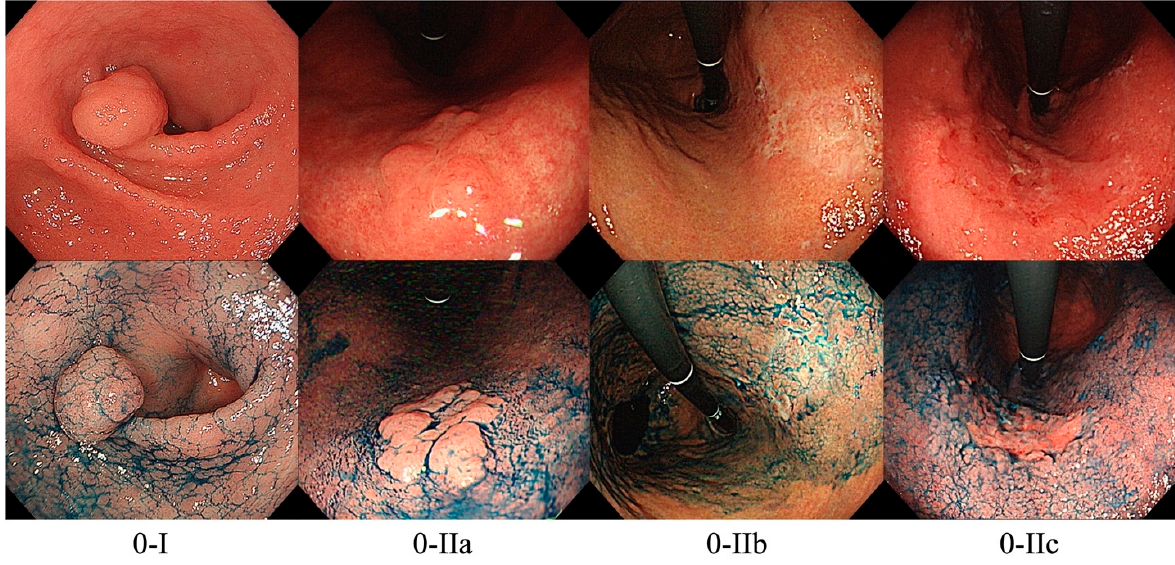
Figure 1. Representative images of the Paris endoscopic classification (upper row: white light only, lower row: same lesions under chromoendoscopy).